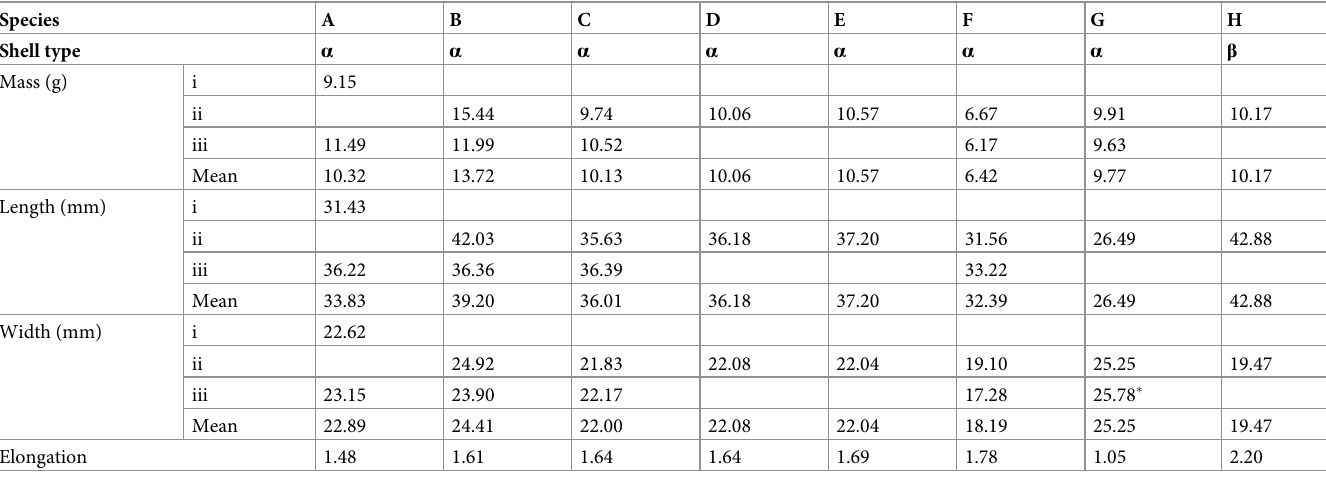
Table 2. Egg characteristics of eight freshwater turtles from South Korea.